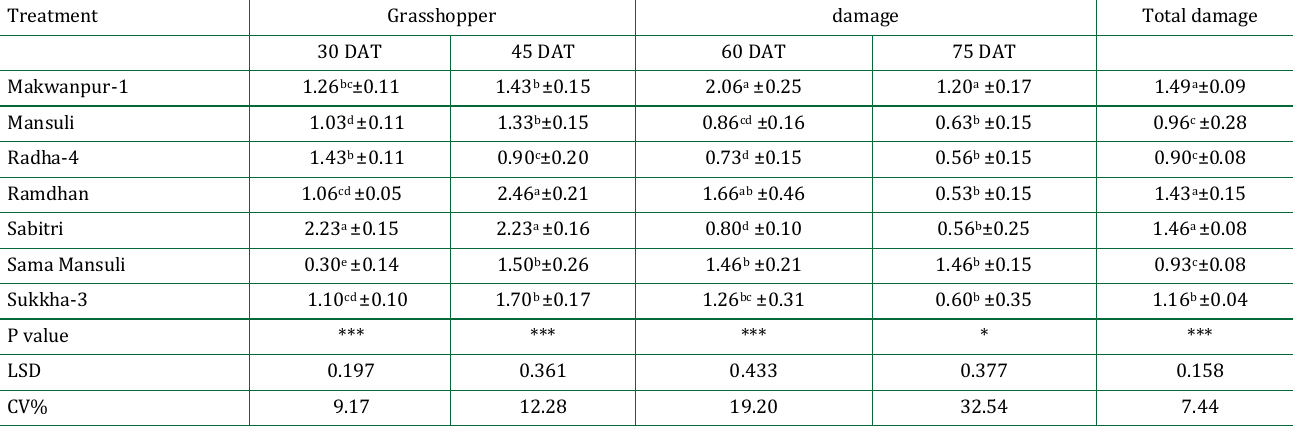
Table 2: Average grasshopper damage score in different rice varieties under field condition in Chitwan, Nepal, 2019 Treatment Grasshopper